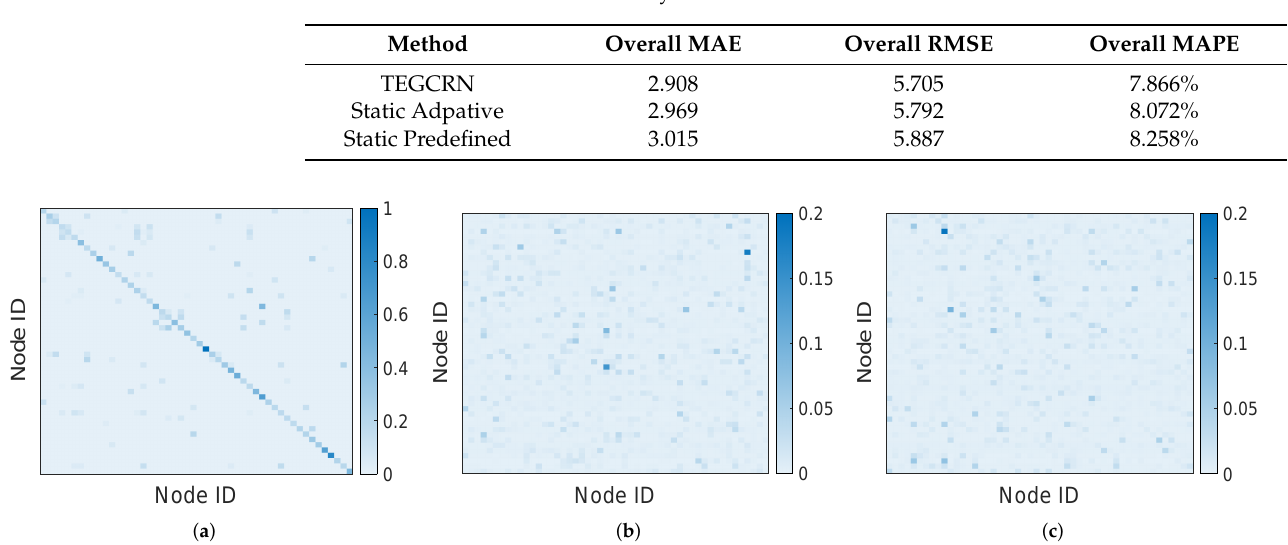
Figure 5. Heatmaps of predefined distance-based graph and the learned time-evolving graphs on METR-LA. ( a ) Distance-based graph. ( b ) Learned time-evolving graph at 08:00. ( c ) Learned time-evolving graph at